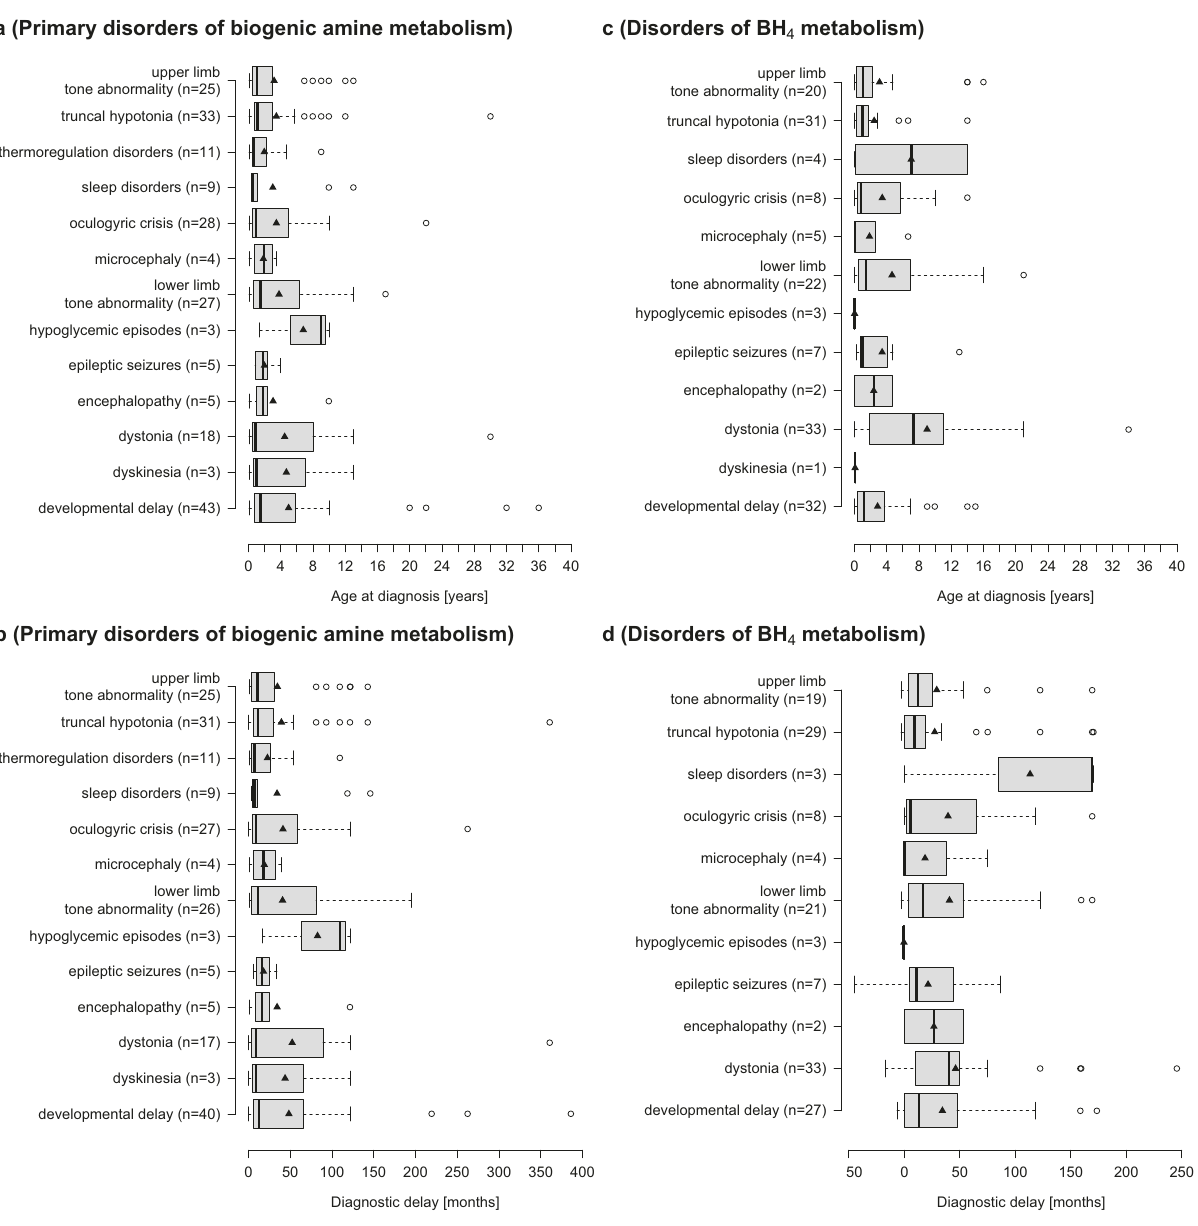
Fig. 5 Association between initial symptoms and age at diagnosis vs. diagnostic delay. Association between initial symptoms and age at diagnosis vs. diagnostic delay in disorders of primary biogenic amine metabolism ( a , b ) and BH metabolism ( c , d ). Diamond: arithmetic mean, bold line: median, boxes present interquartile range (25% and